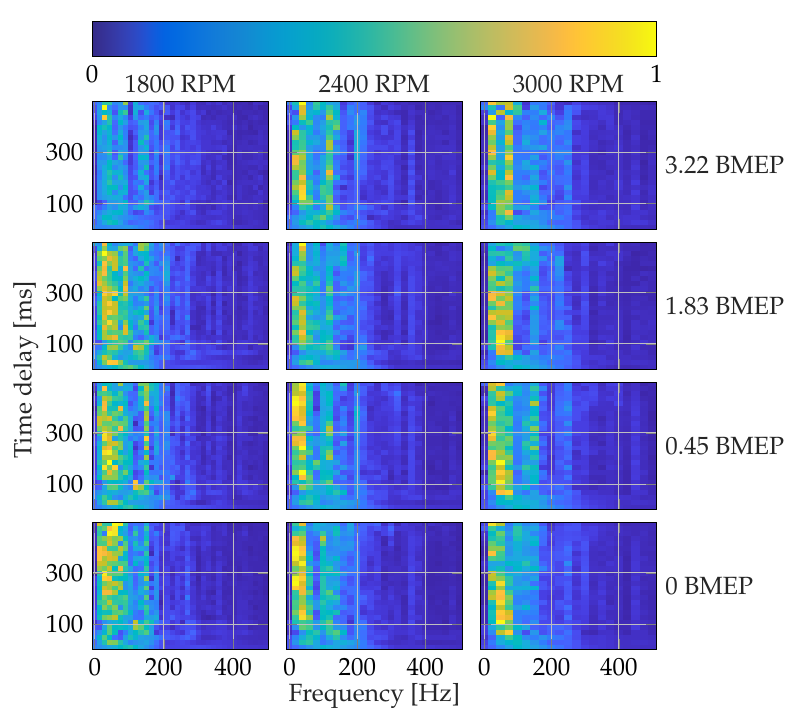
Figure 9. TDNN weights magnitude spectrum. Different K values (maximum time delay), three engine velocities (measured in RPM), and four loads (Table 4) are studied. The color indicates the normalized spectrum magnitude from blue to yellow within [ 0,1 ]